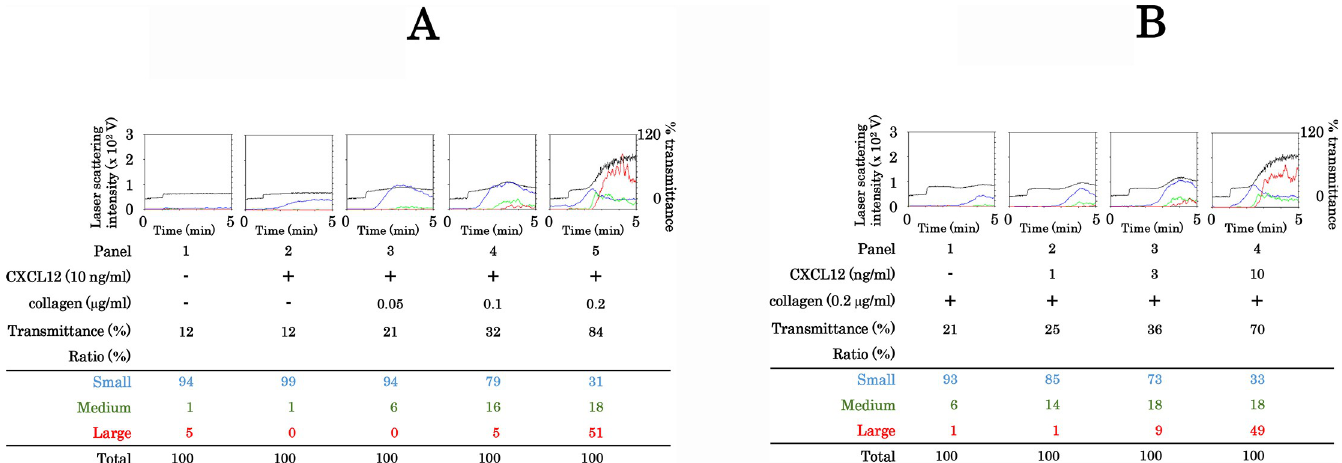
Fig 1. Effect of simultaneous stimulation with collagen and CXCL12 in low doses on platelet aggregation. PRP was simultaneously stimulated by 0.05–0.2 μ g/ml of collagen and 1–10 ng/ml of CXCL12 for 5 min. The reaction was terminated by the addition of ice-cold EDTA (10 mM) solution. The black line indicates the percentage of transmittance of each sample (isolated platelets recorded as 0%, and platelet-poor plasma recorded as 100%). The blue line indicates small aggregates (9–25 μ m); green line, medium aggregates (25–50 μ m); red line, large aggregates (50–70 μ m). The lower panel presents the distribution (%) of aggregated particle size as measured by laser-scattering. The effects of simultaneous stimulation with 10 ng/ml of CXCL12 and 0.2 μ g/ml or less of collagen (A), and simultaneous stimulation with 10 ng/ml or less of CXCL12 and 0.2 μ g/ml of collagen (B) are shown.